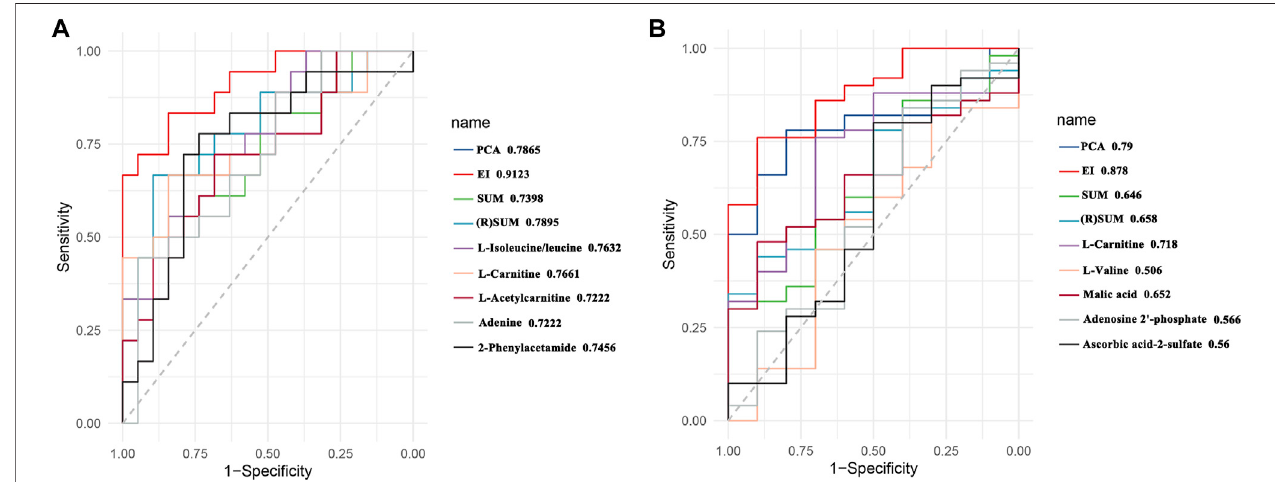
FIGURE 10 | Receiver operating characteristic (ROC) curves of effect (A) and toxicity (B) .